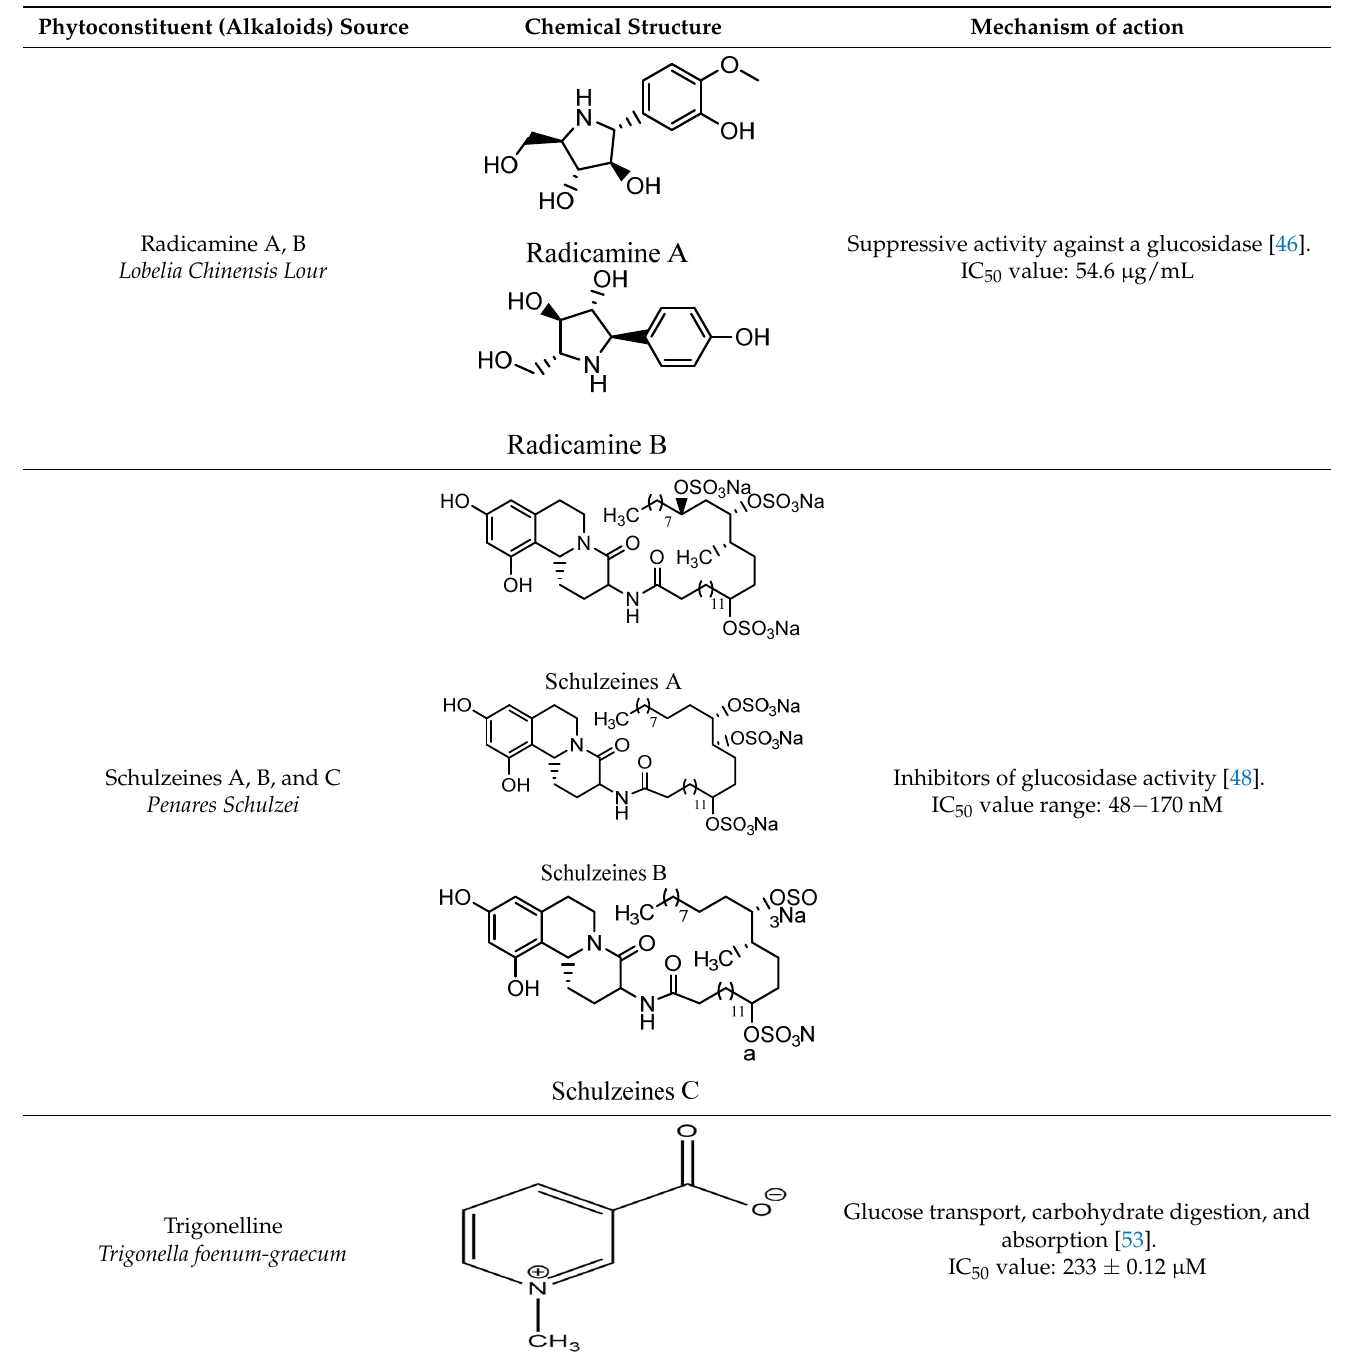
Glucose transport, carbohydrate digestion, and absorption